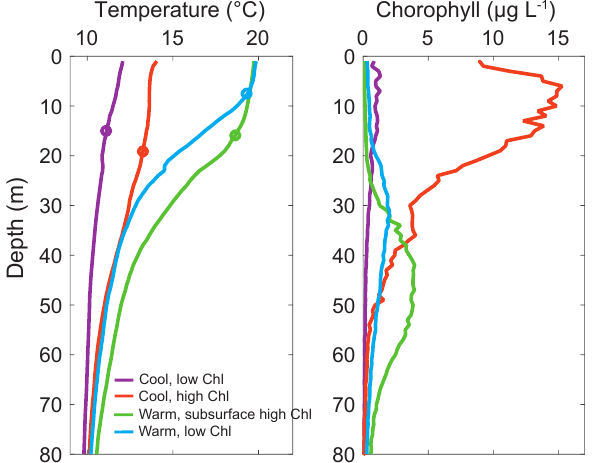
Figure 4. Temperature and chlorophyll profiles for end-member profiles. Average temperature and chlorophyll a profiles for the four end-member profile types in the San Pedro Channel during spring and early summer in 2013 and 2014: cool, low chlorophyll ( n = 12); cool, high chlorophyll ( n = 10); warm, subsurface high chlorophyll ( n = 15); and warm, low chlorophyll ( n = 17). Aver- age mixed-layer depth for each end-member profile is denoted with a circle. Secondary characteristics from these four water column profile types were used to create the structured principal component axes for downstream